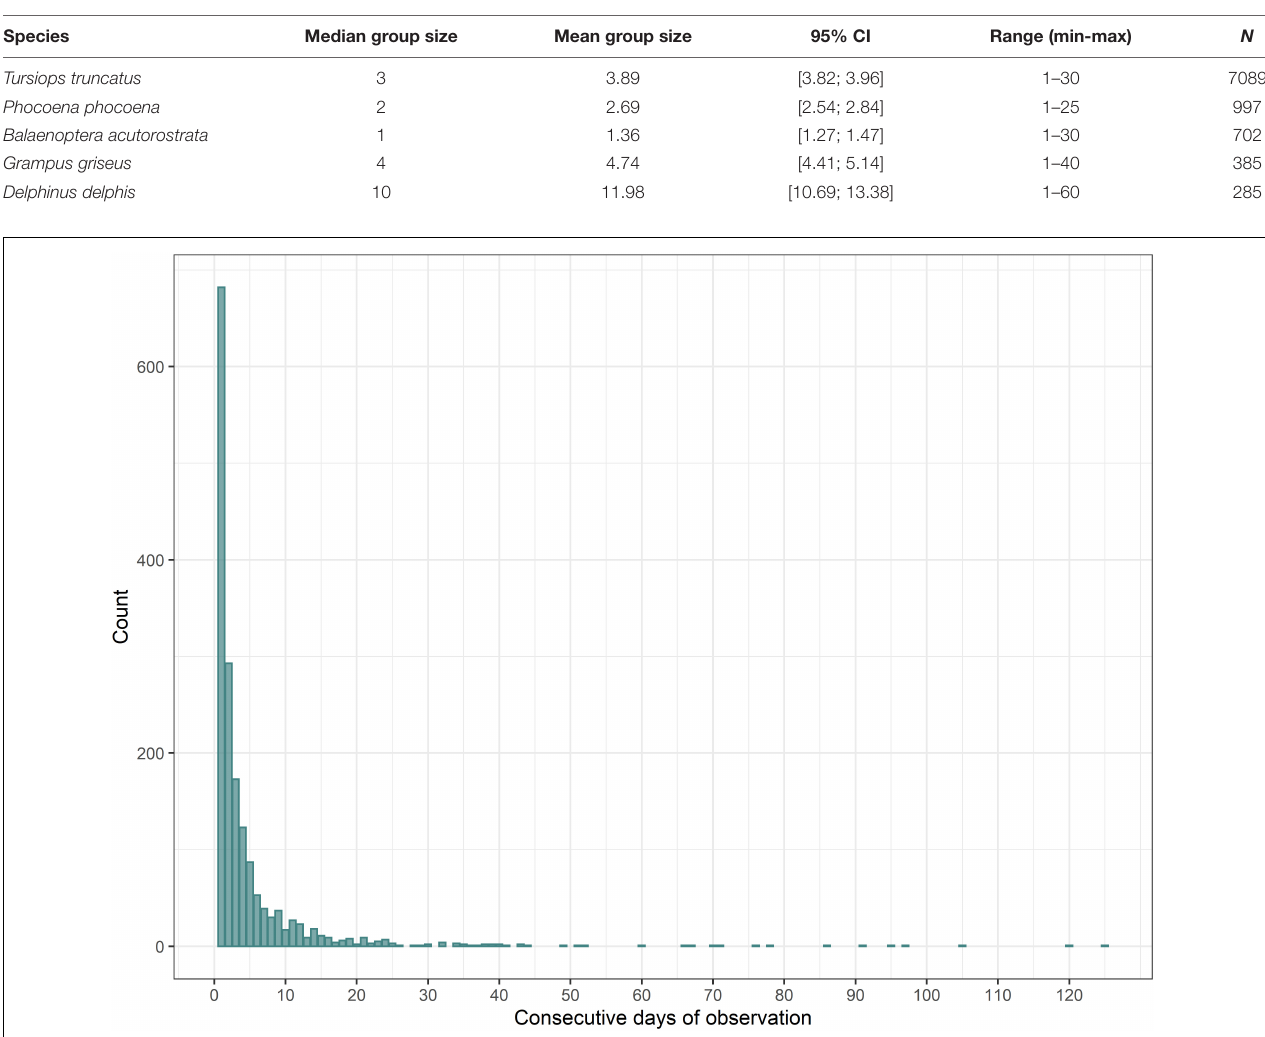
FIGURE 4 | Frequency distribution for length of runs of consecutive observation days. One outlier (length of the run = 276 days) has been excluded.